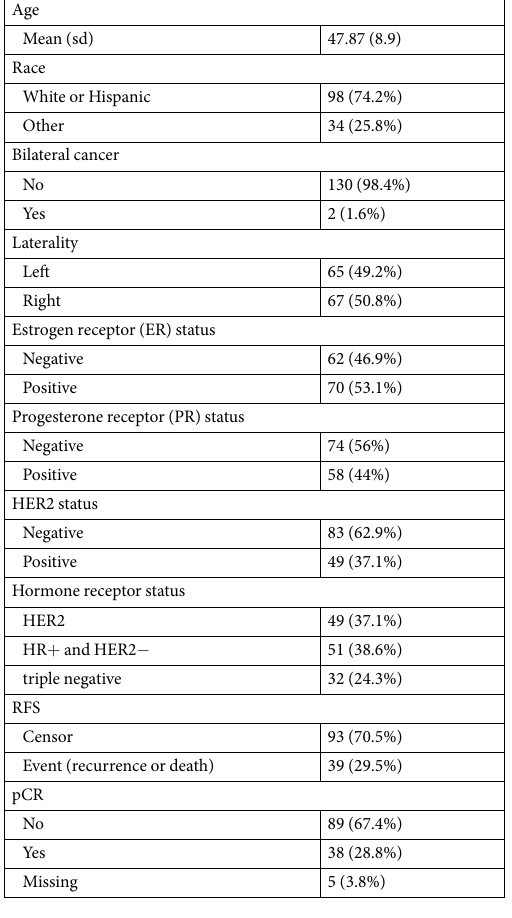
Table 1. Patient characteristics for the ISPY-1/ACRIN 6657 trial sample analyzed in our